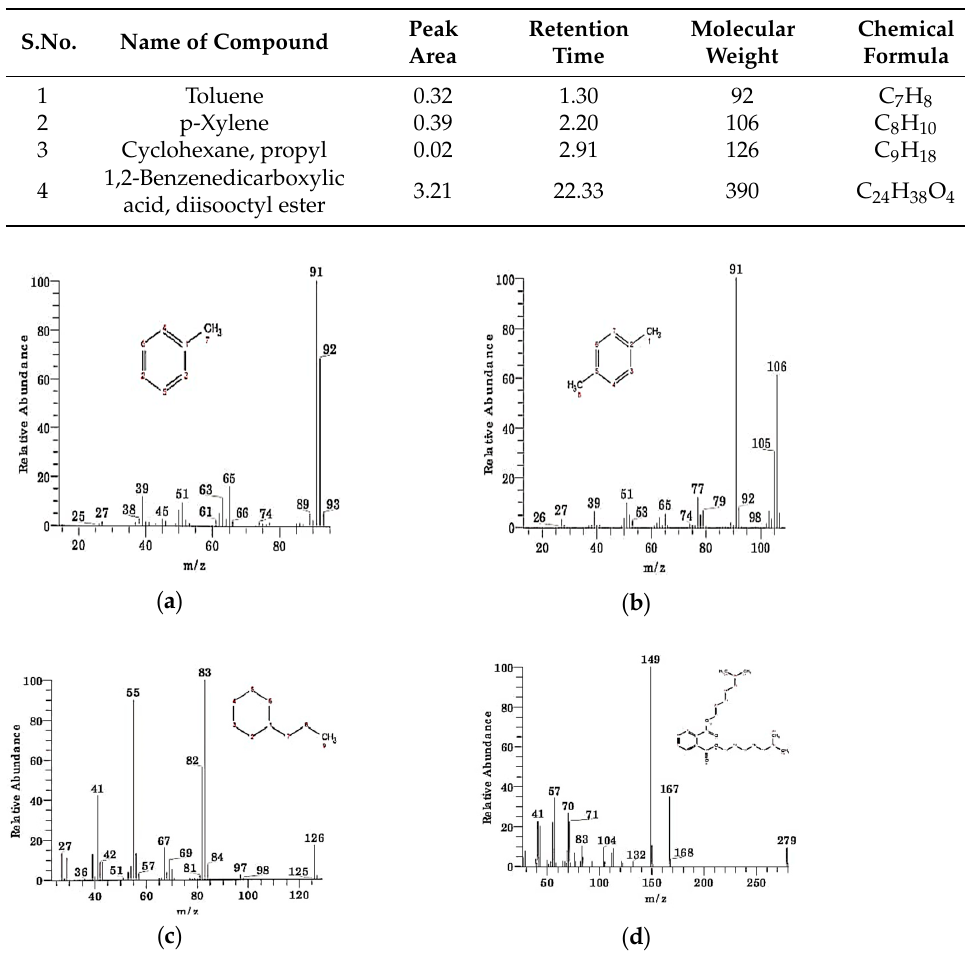
Figure 11. GC-MS chromatograms of mixtures of metabolites ( a ) Toluene ( b ) p-Xylene ( c ) Cyclohexane propyl ( d ) 1,2-Benzenedicarboxylic acid, diisooctyl ester. Table 1. GC-MS analysis and Identified compounds from degraded mixture. S.No.